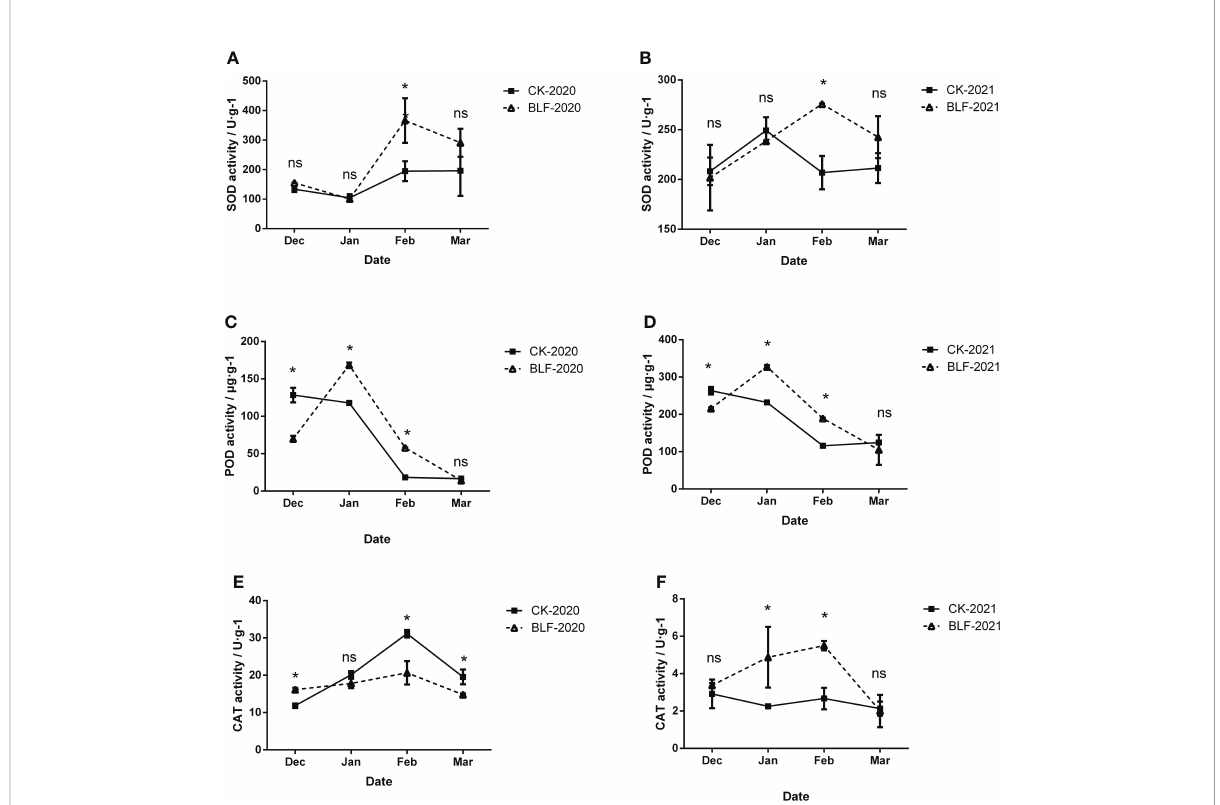
FIGURE 4 Effect of spraying BLF on superoxide dismutase (A, B) , peroxidase (C, D) , and catalase (E, F) activities on 2020 and 2021. “ * ” means that the average value of each parameter is signi fi cant between the two treatments (p<0.05), and ns means no signi fi cance by Duncan ’ s multiple range test.